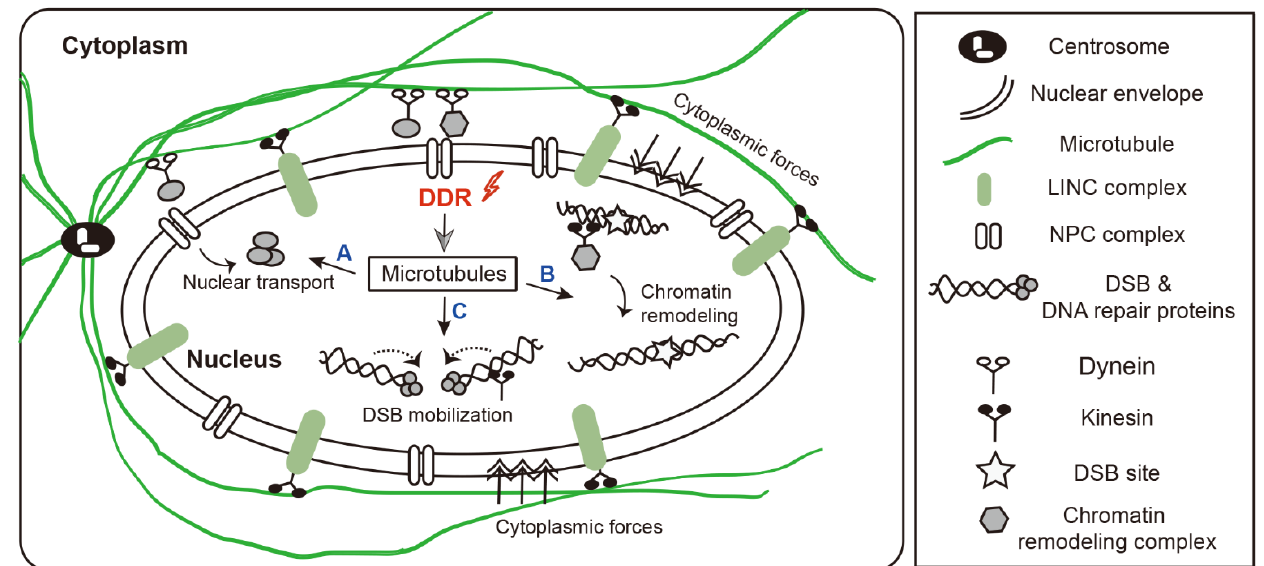
Figure 1. The role of microtubule dynamics in DNA damage response. Microtubules are involved in DNA damage repair at three main levels. ( A ) Centrosomes organize microtubules by controlling nucleation and anchoring processes. Cytoplasmic microtubules can mediate the transport of DNA repair factors into the nucleus. ( B ) Dynamic cytoplasmic microtubules physically interact with and exert mechanical forces onto nuclear envelope, which can impact nuclear morphology, leading to changes in chromatin structure. In addition, nuclear localization of microtubule components induces chromatin reorganization. These changes expose DNA damage sites, allowing access to various DNA repair proteins. ( C ) Microtubules/LINC complexes increase the mobility of damaged DNA and promote the recruitment of DNA repair proteins at the site of damage, which is important for DSB repair via both HR and NHEJ. Abbreviations: LINC, linker of the nucleoskeleton and cytoskeleton; NPC, nuclear pore complex.